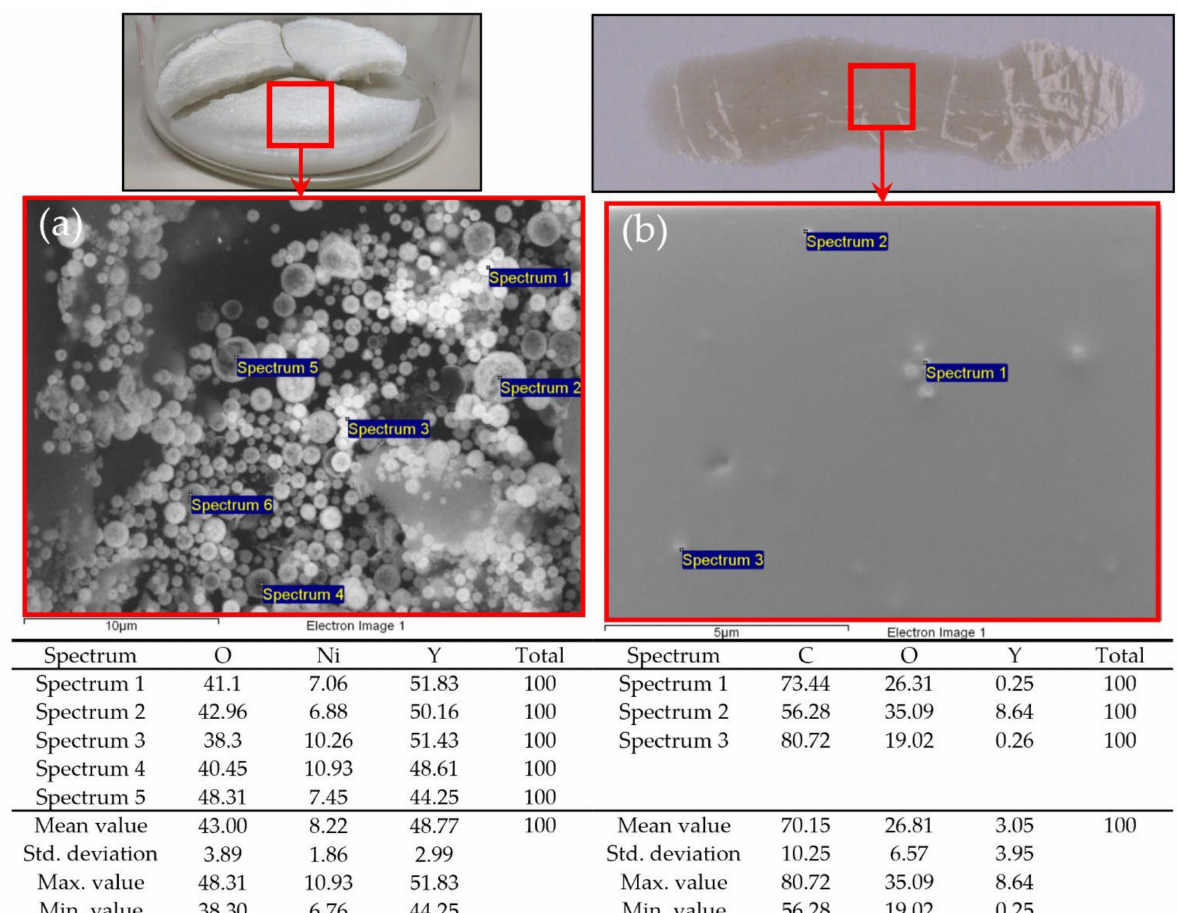
Figure 7. SEM/EDX analysis of the: ( a ) dried Ni/Y 2 O 3 -0.025/0.100 sample and ( b ) applied coating.